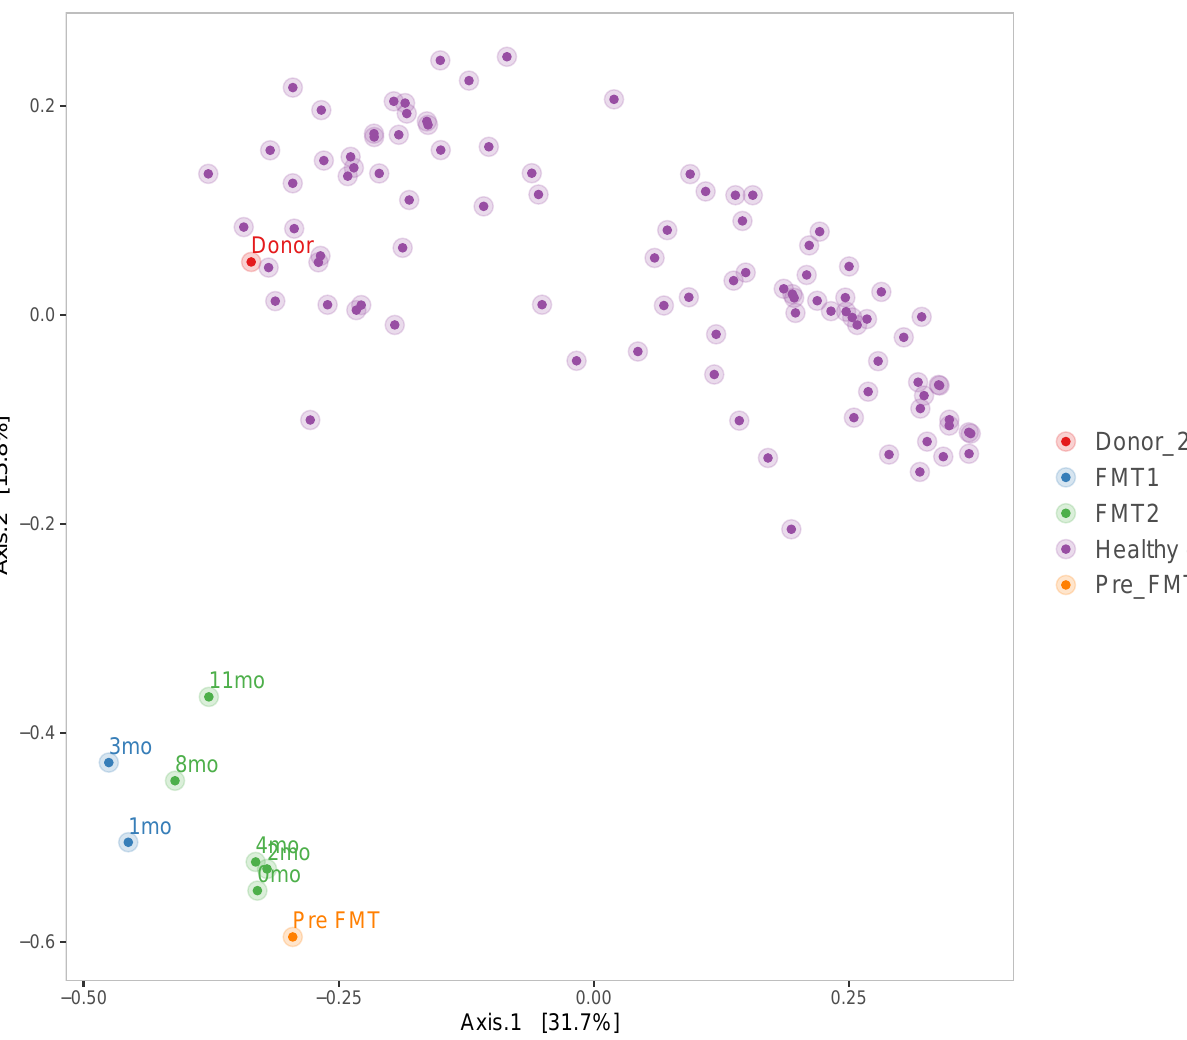
Figure 3. PCoA plot on Bray–Curtis beta diversity measure. The normalized (GMPR) data are represented with different colours to highlight different groups: purple for healthy controls, light blue for samplings after the first FMT, green for samplings after the second FMT, orange and red for pre-FMT and Donor_2 samples,